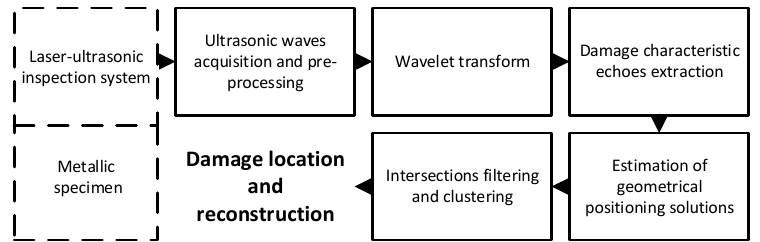
Figure 1. The sequence flow chart of the proposed laser ultrasound imaging methodology composed of five stages.